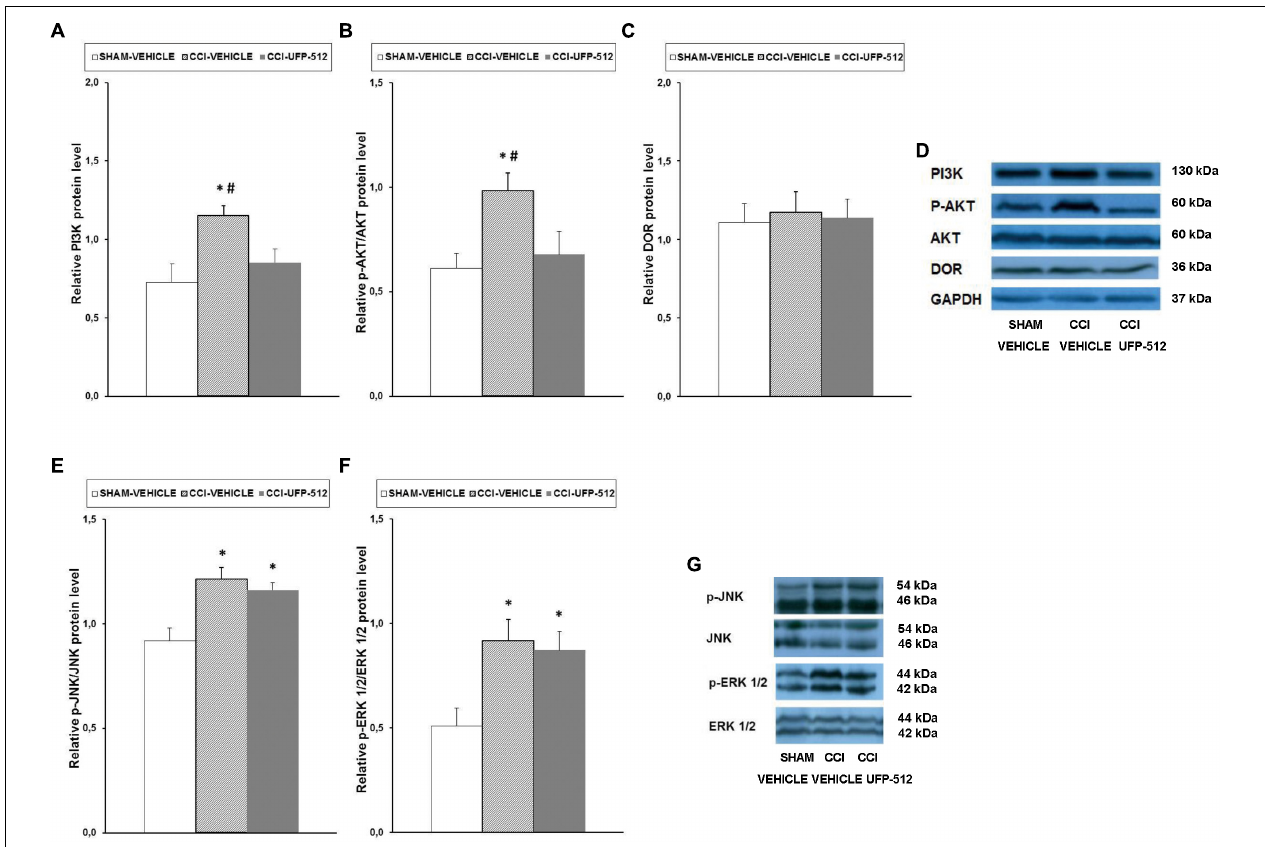
FIGURE 7 | Effects of UFP-512 on the expression of PI3K, p-Akt, DOR, p-JNK, and p-ERK 1/2 in the spinal cords of animals with neuropathic pain. Protein levels of PI3K (A) , p-Akt (B) , DOR (C) , p-JNK (E) , and p-ERK 1/2 (F) in the ipsilateral site of the spinal cord from CCI-injured mice treated with UFP-512 (CCI-UFP-512) or vehicle (CCI-vehicle) are represented. Controls corresponding to sham-operated mice treated with vehicle (sham-vehicle) are also shown. For each protein, ∗ indicates significant differences vs. sham-operated mice treated with vehicle and # indicates significant differences vs. CCI-injured mice treated with UFP-512 ( P < 0.05, one-way ANOVA, followed by the Student–Newman–Keuls test). Representative examples of western blots for PI3K (130 kDa), p-Akt (60 kDa), Akt (60 kDa), DOR (36 kDa), and GAPDH (37 kDa) are shown in (D) and for p-JNK/total JNK protein (46–54 kDa) and p-ERK 1/2/total ERK 1/2 (42–44 kDa) in (G) . Phosphorylated proteins are expressed relative to their corresponding total proteins while the rest are relative to GAPDH. Results are expressed as mean ± SEM; n = 4 samples per